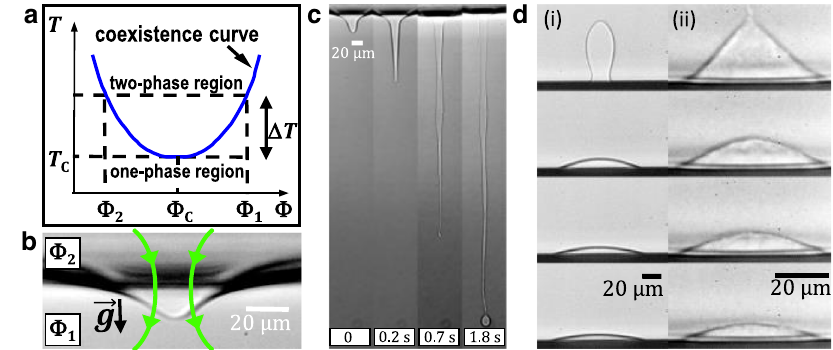
Fig.1|Experimentalsystem.a Schematicphasediagramoftheusedbinaryliquid mixture(i.e.,amicellarphaseofthemicroemulsion,seeSupplementaryMethod1), where T is the temperature, Φ the micelle concentration, and T c and Φ c the coor- dinates of the critical point. b Radiation pressure-induced optical bending of the interfaceseparating the twocoexisting phases at T > T c , where the downwardlaser beam is represented by the arrows. c Image sequence of the optical jetting